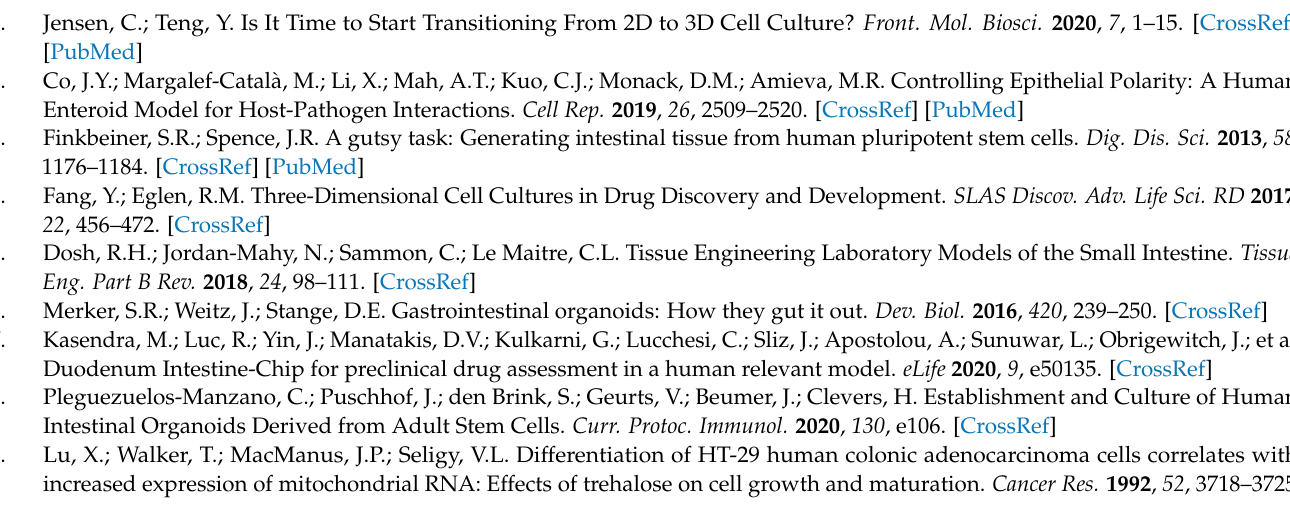
Figure S7: Magnified images of cell clusters on topographic surfaces stained for